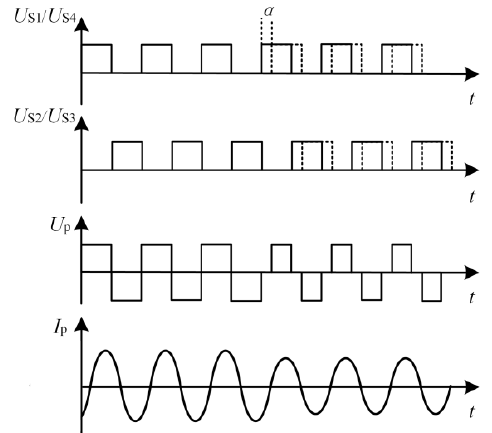
Figure 2. Inverter working waveform.